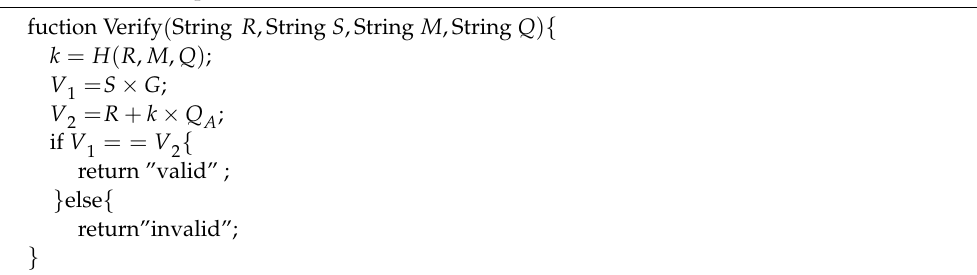
Algorithm 3: The process of EdDSA verification between role A and role B.